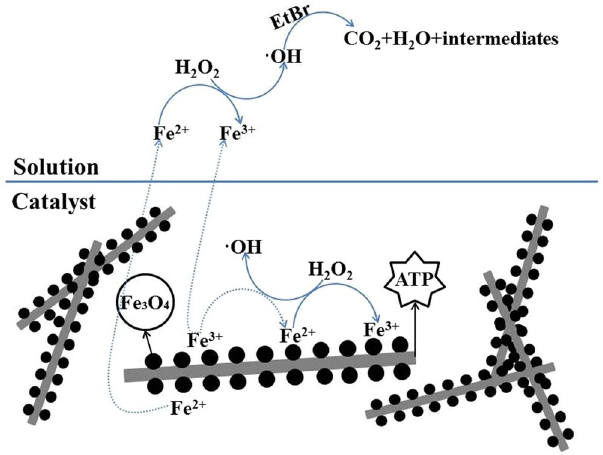
Figure 8. Schematic diagram of the reaction mechanism of the H 2 O 2 activation by A-ATP@Fe 3 O 4 catalyst under acidic